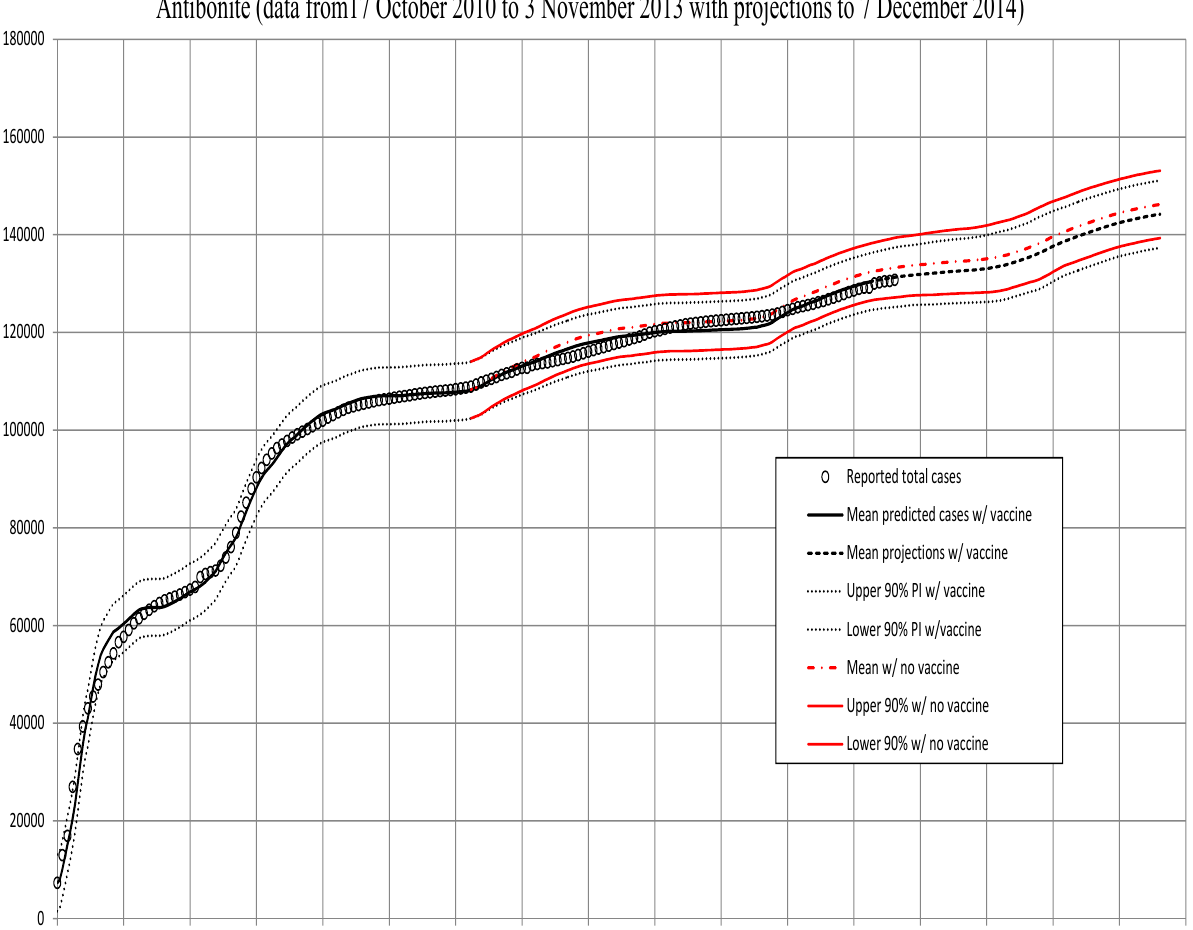
Figure 2. Artibonite. The predicted cumulative number of symptomatic individuals, against total reported cases to 1 April 2012. Projections are from then to the end of February. Projections using the vaccination schedule (red) begin on 7 May 2012, approximately three weeks after beginning the vaccination program in Artibonite. All projections after 11 November 2012, are based on runs using the prior 13 years of precipitation, and PI’s include the variance of those data (see the text). Predicted and Reported Cumulative Number of Cases vs.